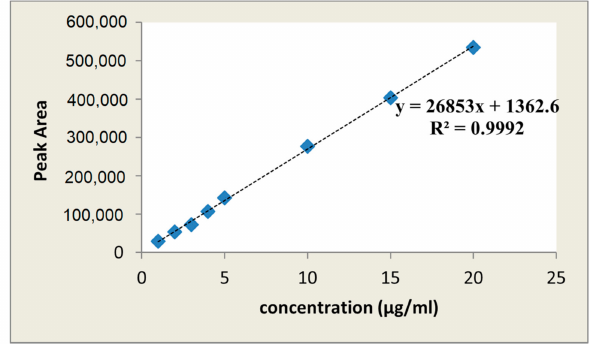
Figure 3. Standard curve of linearity for paracetamol.